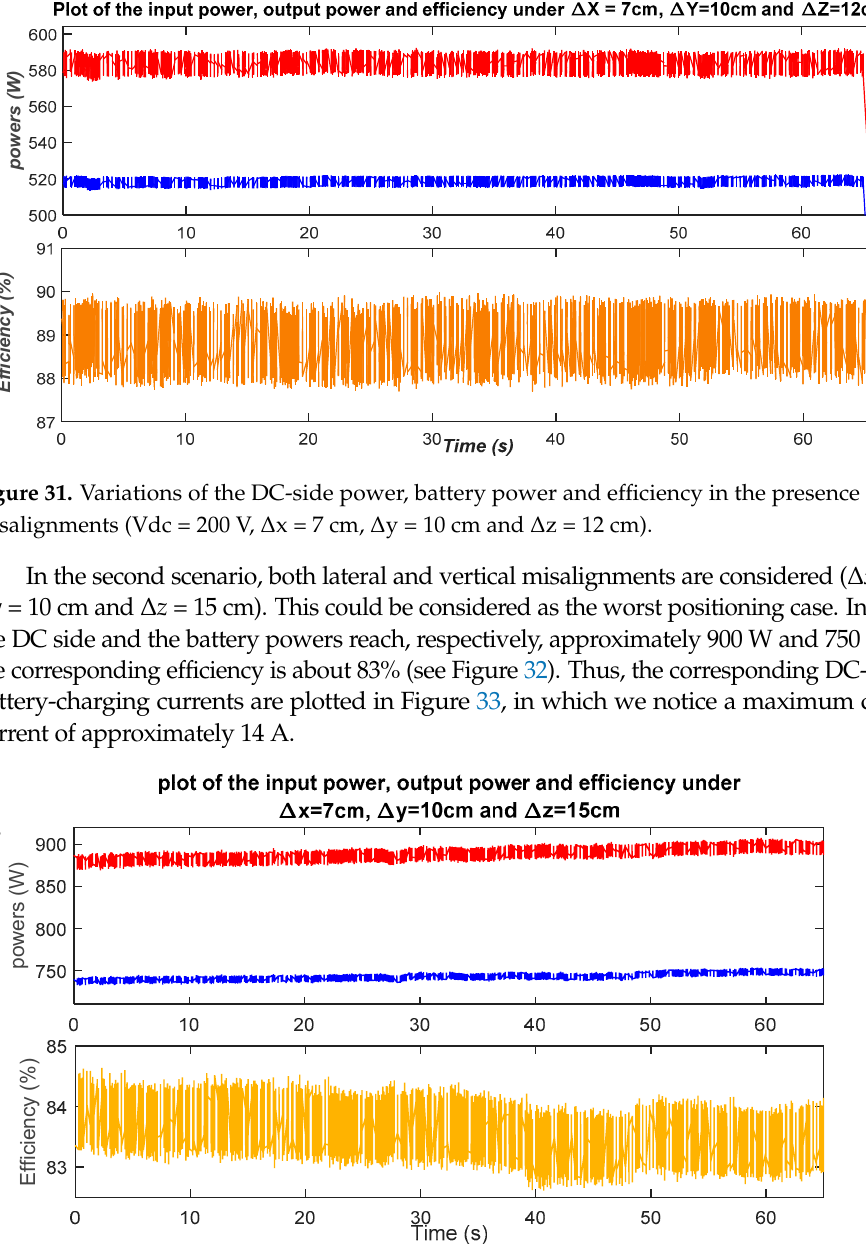
Figure 32. Variations of the DC-side power, battery power and efficiency in the presence of lateral and vertical misalignments (Vdc = 200 V, Δ x = 7 cm, Δ y = 10 cm and Δ z = 15 cm).